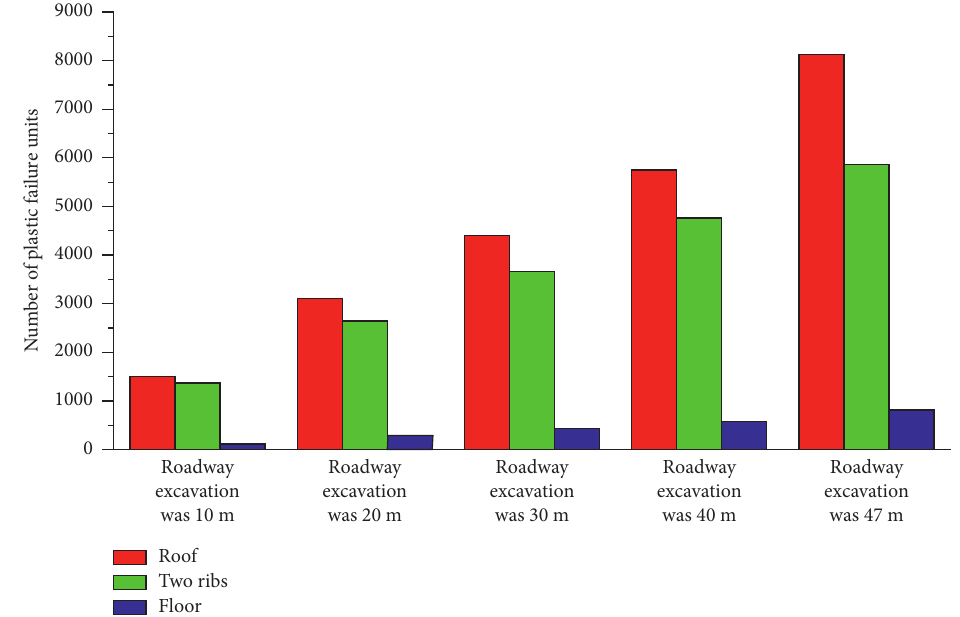
Figure 12: Evolution of surrounding rock plastic zone during roadway